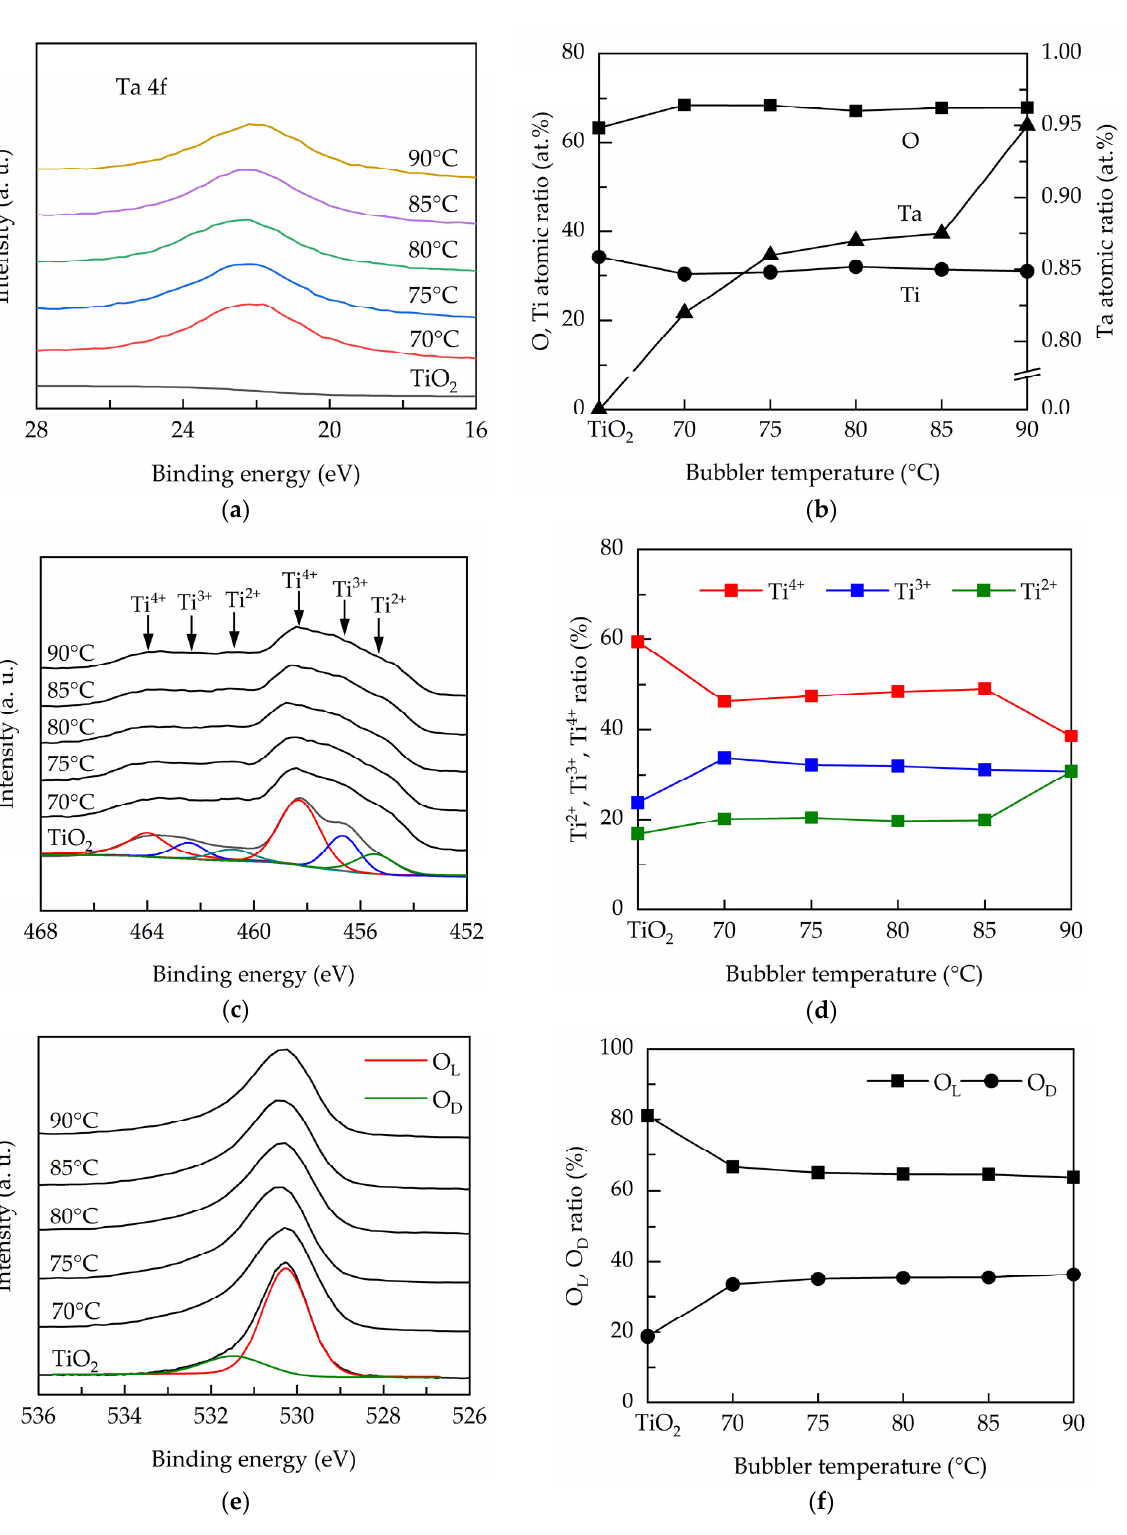
Figure 4. ( a ) Ta 4f spectra, ( b ) O, Ti and Ta atomic ratios, ( c ) O 1s spectra, ( d ) O L and O D peak area ratios, ( e ) Ti 2p 3/2 spectra, and ( f ) Ti 2+ , Ti 3+ and Ti 4+ peak area ratios for the PEALD Ta-doped TiO 2 films.